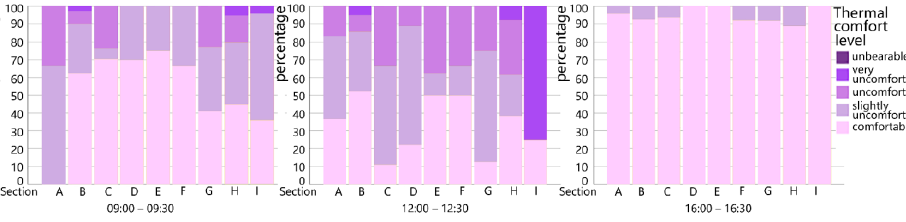
Figure A11. Thermal comfort votes of the three time periods on 11 September.